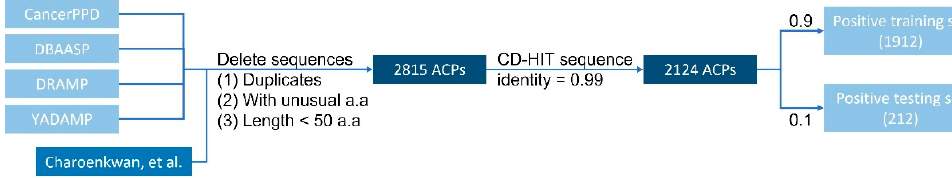
Figure 3. Positive data collection and division process.